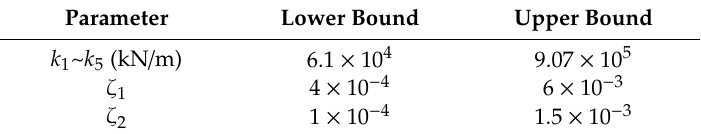
Table 6. Bounds of the prior uniform distributions for the parameters of the 5-DOF model.